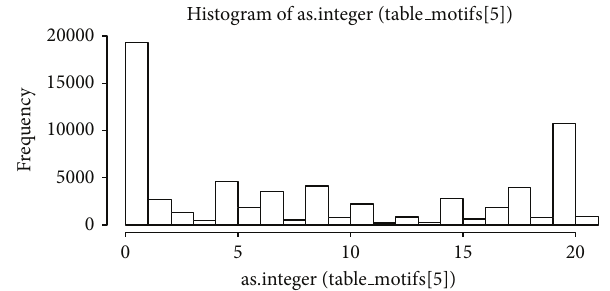
Figure 5: Histogram of number of found motifs per nested group.